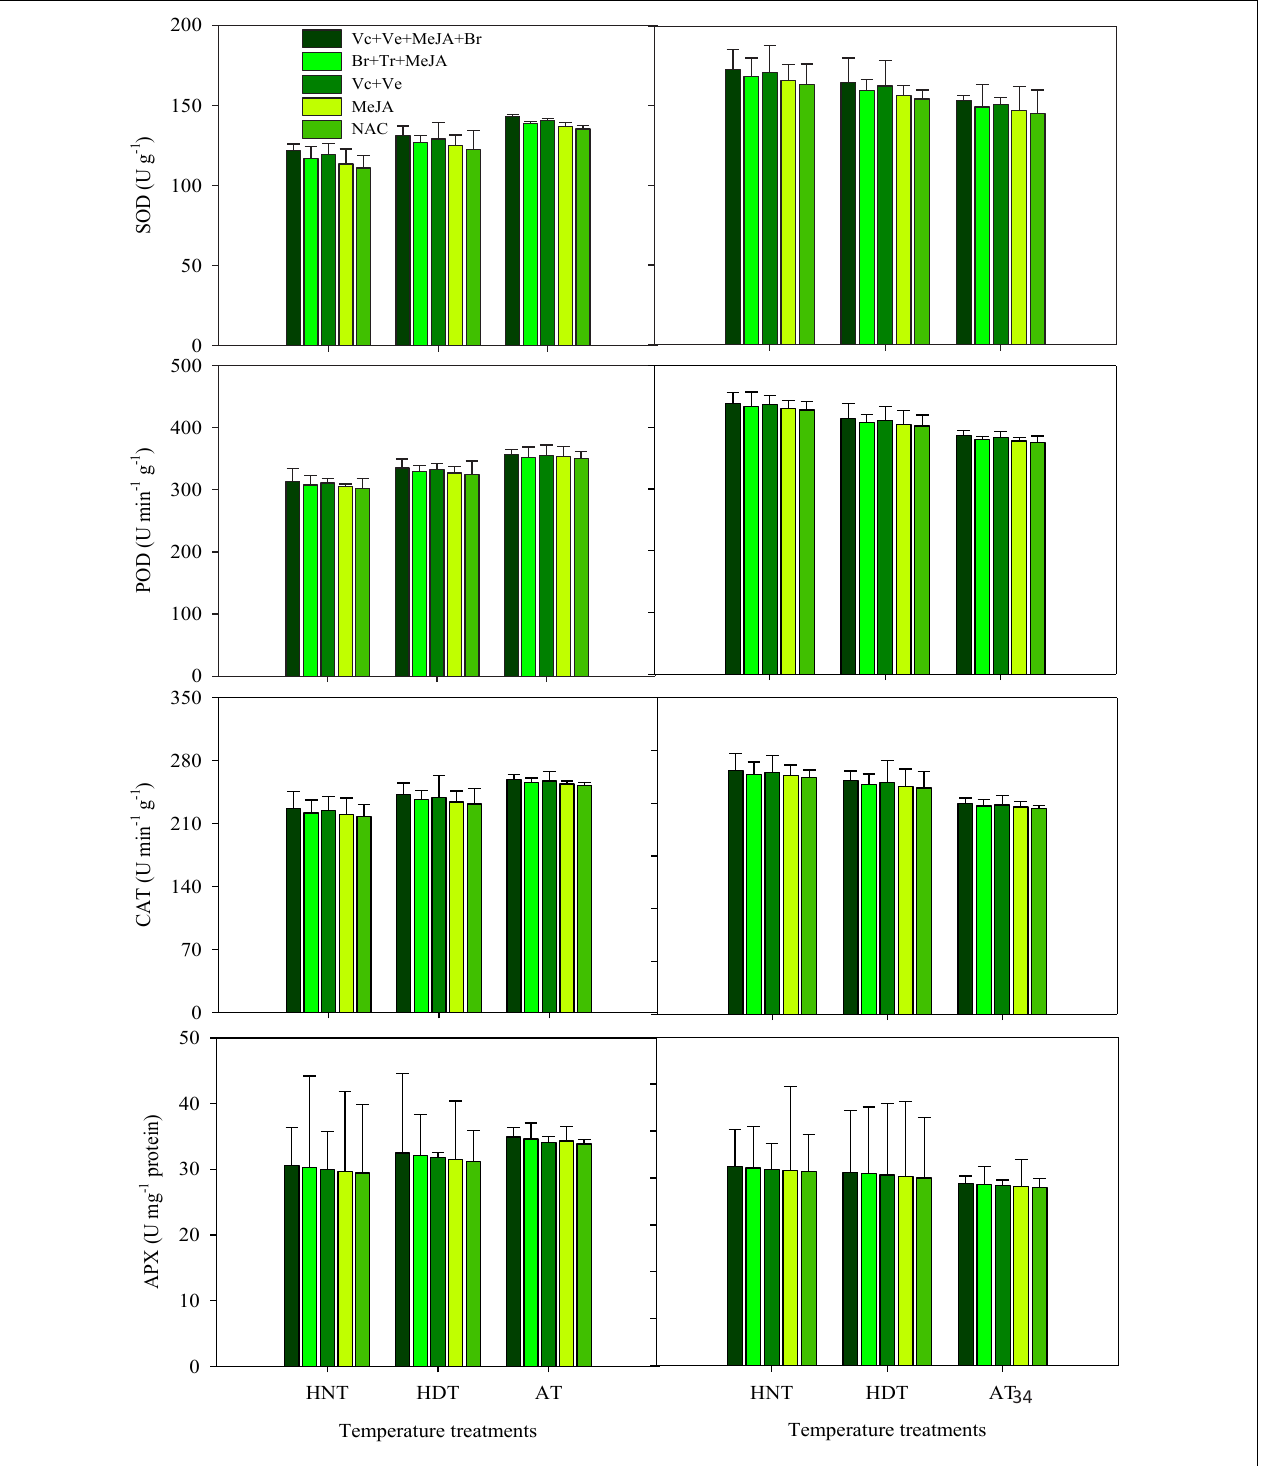
FIGURE 1 | Catalase (CAT), ascorbate peroxidase (APX), superoxide dismutase (SOD), peroxidase (POD) accumulation in rice leaves as influenced by growth regulators under heat stress. HDT, HNT, and AT stand for high day, high night, and ambient temperature, respectively. The lines on bars represent LSD value for the interaction of PGRs and heat stress (heat stress × PGR) at α = 0.05.